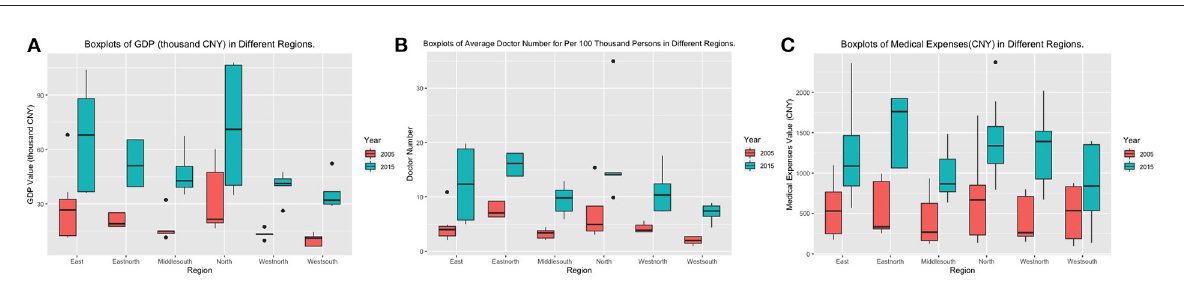
TheunitofGDPinthistableisonethousandCNY,andthedoctornumberreferstotheaveragedoctornumberperhundredthousandpersonswithineachregion,andvaluesinparentheses representthecorrespondingstandarddeviation.